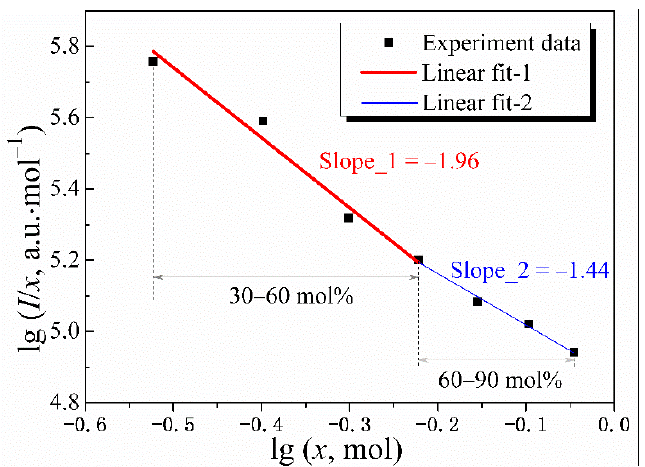
Figure 5. Plots of lg( I / x ) versus lg x of Gd 2 (MoO 4 ) 3 : x Er 3+ phosphors under 976 nm excitation.